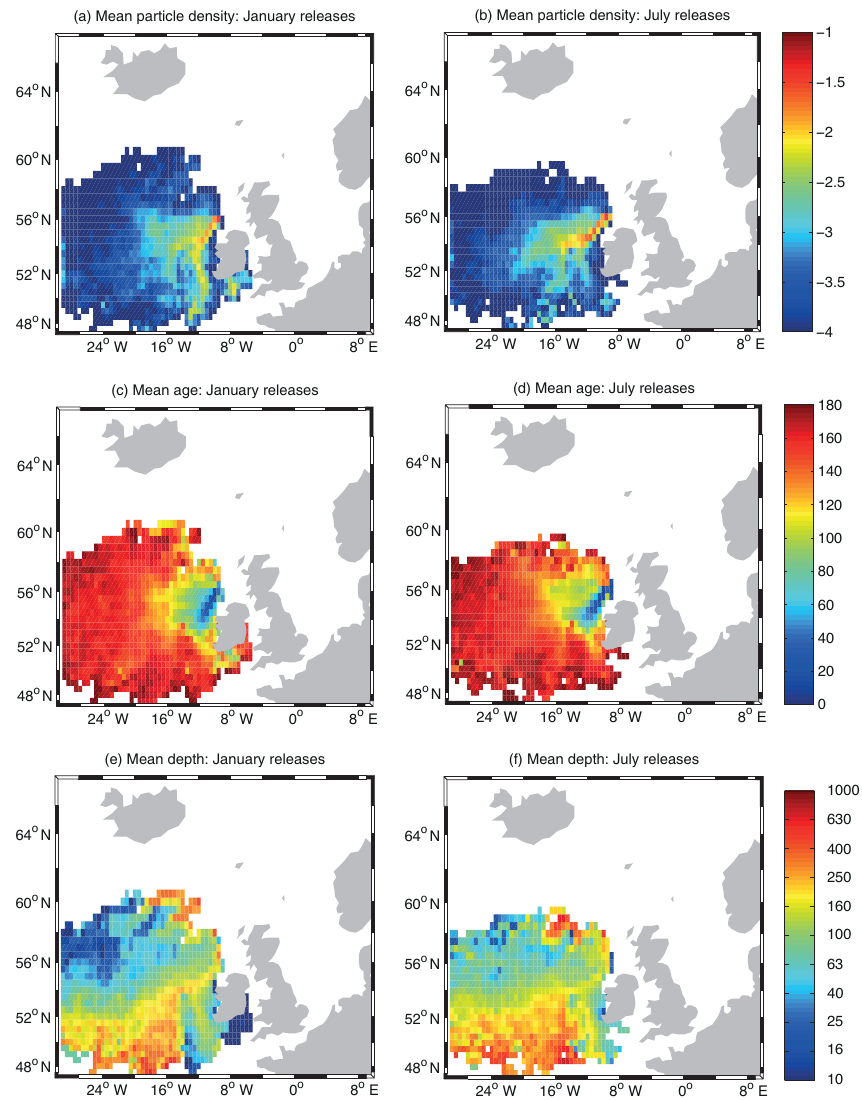
Figure 3. As in Fig. 2a–f, for backward trajectories.